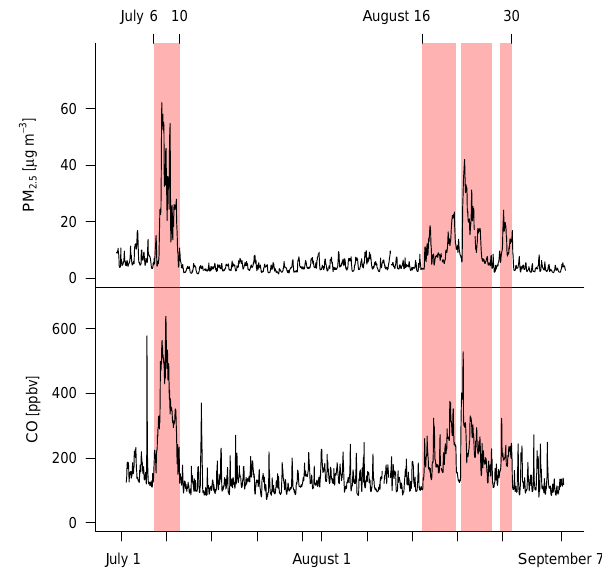
Figure 1. Top panel: time series of hourly PM 2 . 5 concentrations for the CDPHE CAMP air quality monitoring site (www.epa.gov/ airdata) located in downtown Denver (39.75 (cid:48) , − 104.98 (cid:48) ). Bottom panel: time series of hourly CO mixing ratios at the Boulder Atmo- spheric Observatory (BAO: 40.05 (cid:48) , − 105.01 (cid:48) ). Red shading denotes periods during which smoke is present at